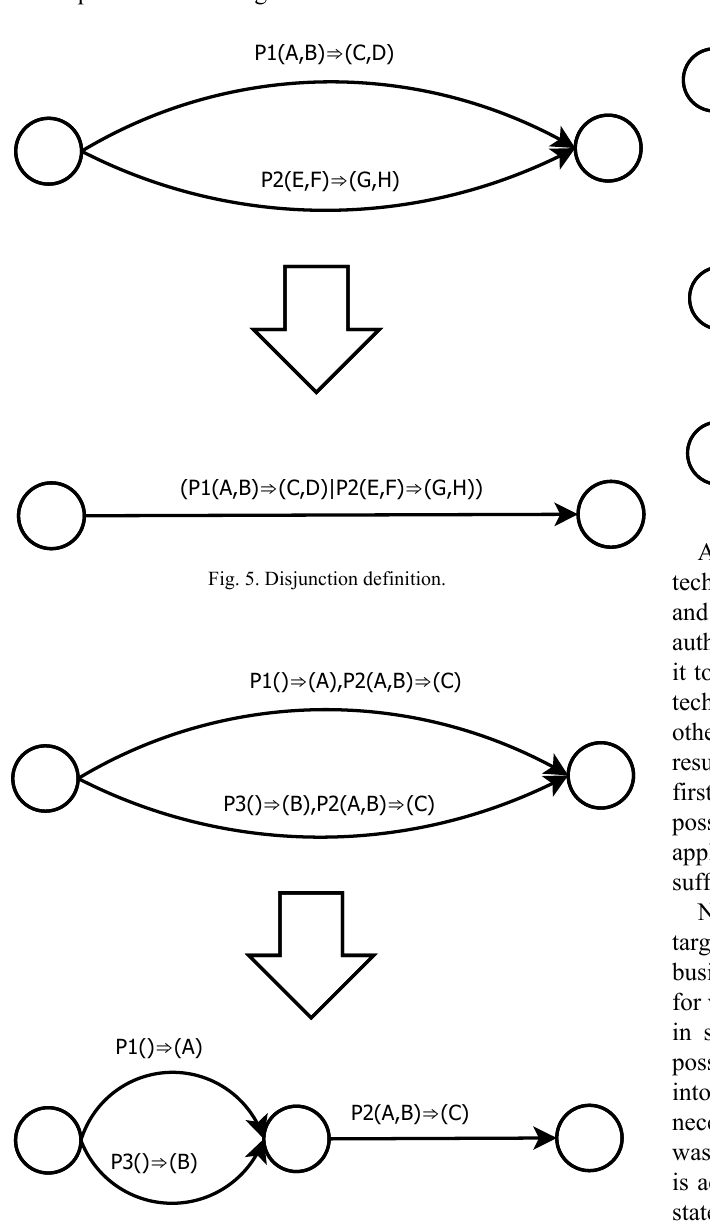
Fig. 6. The first common suffix processing technique.